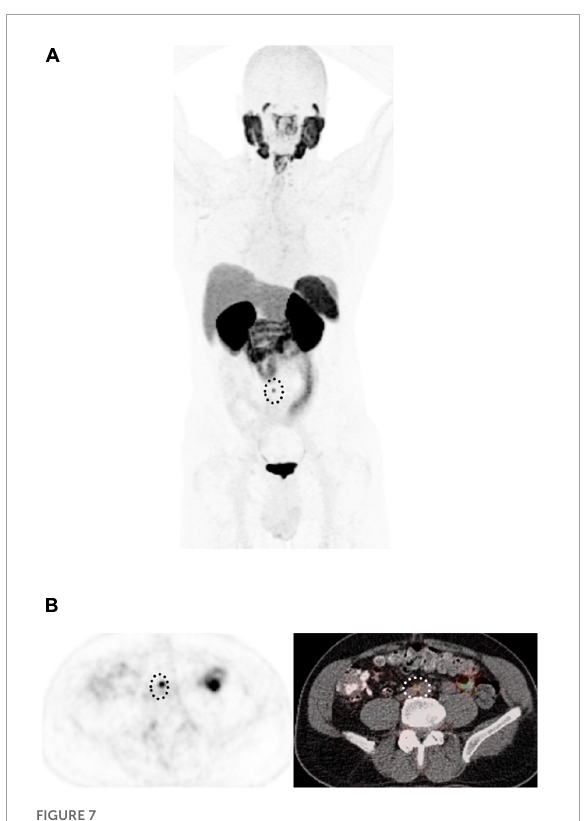
FIGURE7 58-year-old man with biochemical recurrence of prostate cancer following radical prostatectomy. (A) Maximum intensity projection 18 F-DCFPyL PET and (B) Axial PET (left) and fused PET/CT images show a single 5 mm PSMA-avid retroperitoneal lymph node (dotted circle), with miPSMA score of 2, PROMISE positive, in keeping with extraregional nodal